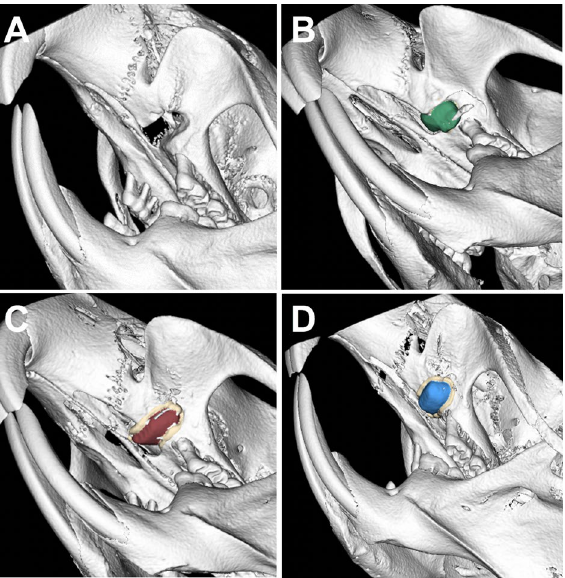
Figure 4. Three-dimensional micro-CT volume rendering after ( A ) cleft creation (µCT T0) and immediately after cleft repair (µCT T1) using ( B ) autologous bone (green), ( C ) xenogeneic/human bone (red), and ( D ) synthetic (β-TCP/HA) bone substitute (blue) and the surrounding alveolar bone (beige